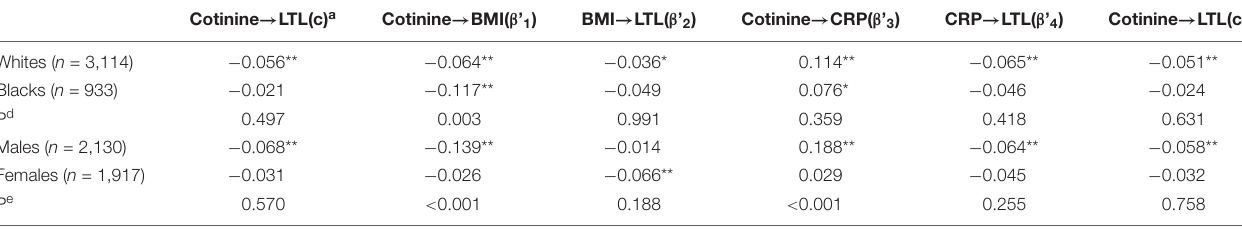
TABLE 3 | Differences in effects of serum cotinine, BMI and Log-CRP on LTL between race and sex groups. Cotinine → LTL(c) a Cotinine → BMI( β ’ 1 ) BMI → LTL( β ’ 2 ) Cotinine → CRP( β ’ 3 ) CRP → LTL( β ’ 4 ) Cotinine → LTL(c’)